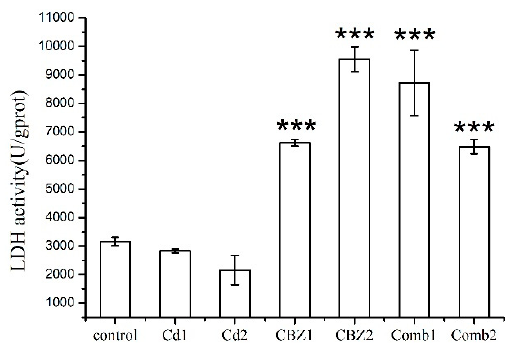
Figure 3. Lactate dehydrogenase (LDH) activity in female fish after ten days of exposure to Cd, CBZ, and Cd + CBZ. The results of one-way ANOVA are indicated at the significance levels *p < 0.05, **p < 0.01, and ***p < 0.001.